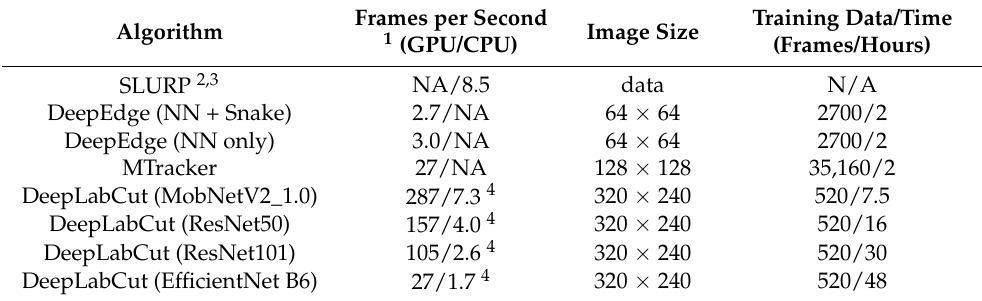
Table 2. Comparison of ultrasound contour tracking algorithms showing the analysis frame rate, image size, training frame rate, and time for the network training to converge. Training Frames per Second Algorithm 1 (GPU/CPU) Image Size